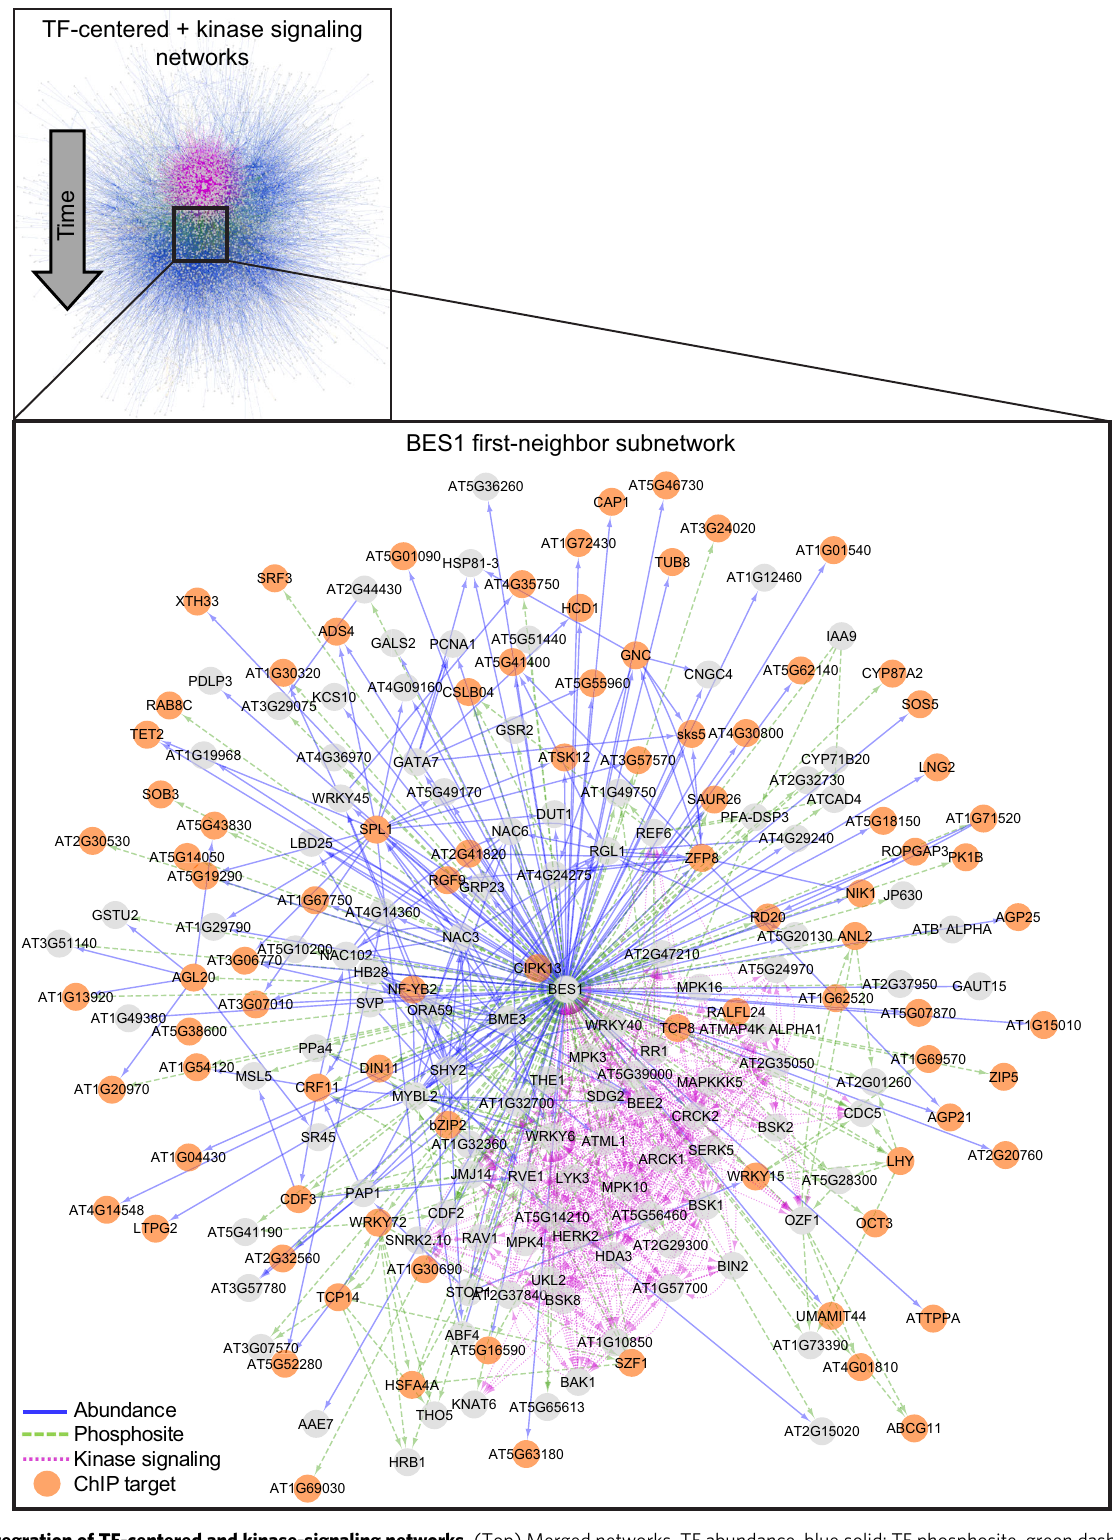
Fig. 3 Integration of TF-centered and kinase-signaling networks. (Top) Merged networks. TF abundance, blue solid; TF phosphosite, green dashed; kinase signaling, purple dotted. The network is arranged temporally, with early regulations at the top and later regulations towards the bottom. (Bottom) First- neighbor subnetwork of BES1. Genes are gray circles. Orange genes are BES1 and BZR1 ChIP-Seq